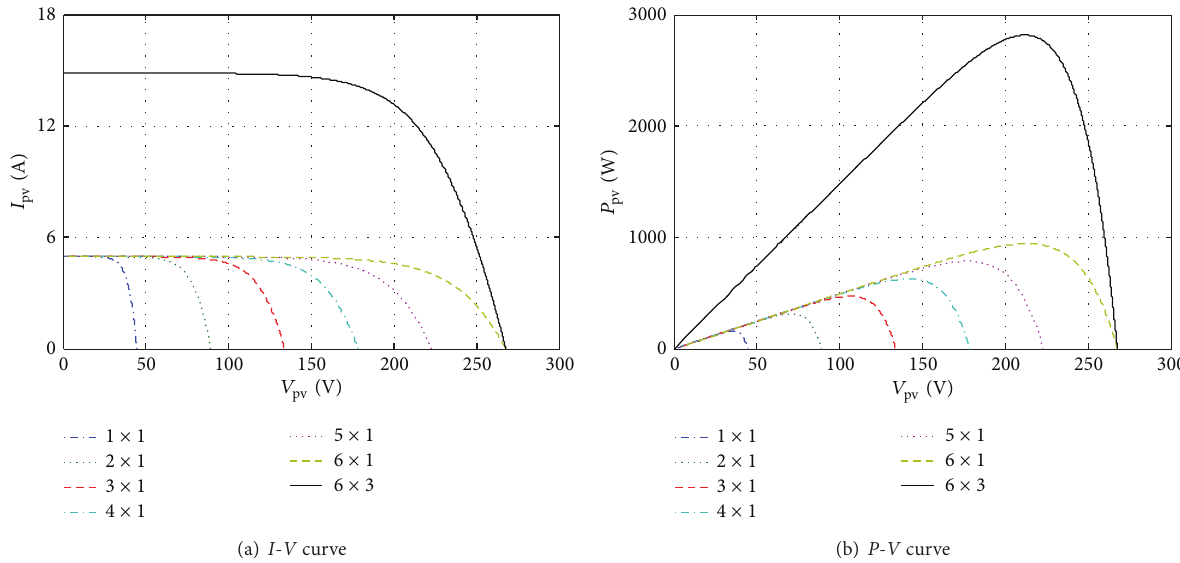
Figure 2: I - V and P - V characteristic curve under normal condition.